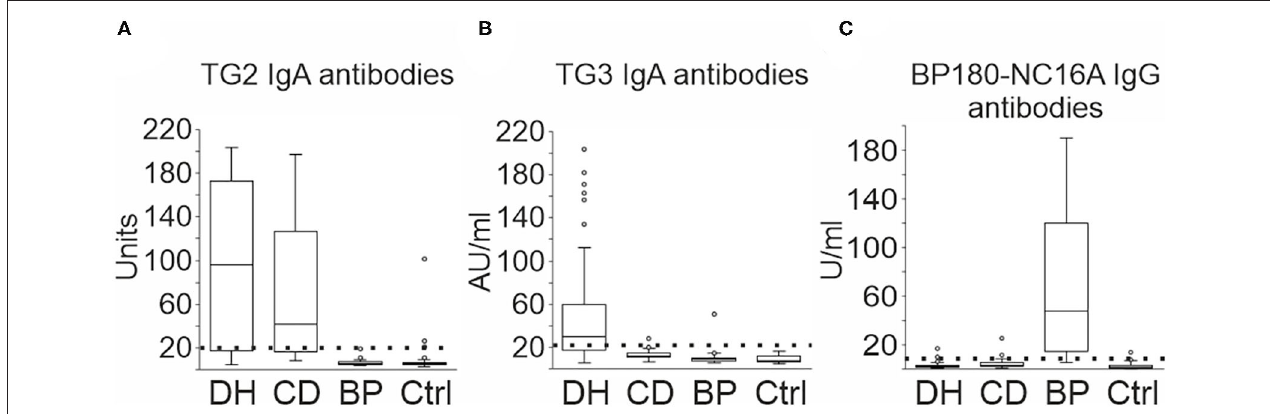
FIGURE 1 | TG2, TG3, and BP180-NC16A autoantibodies in DH, CD, and BP serum samples. 46 DH, 43CD and 34 BP, and 48 control sera were tested for IgA or IgG reactivity against TG2, TG3, and BP180-NC16A using ELISA. (A) Increased TG2 IgA autoantibodies were detected in 33 DH samples, 31CD samples, and 3 controls. (B) Increased TG3 IgA autoantibodies were detected in 29 DH samples, one CD, and one BP sample. (C) Increased BP180-NC16A IgG autoantibodies were detected in 28 BP, three DH, two CD, and two control samples. The boxplot represents the distribution of values in varying units as given by the manufacturer. Boxes depict the 25 and 75th percentiles (interquartile range, IQR) and line in the box is median. Whiskers indicate last values within 1.5 times the IQR from the median, and outliers are marked with circles. BP, bullous pemphigoid; CD, coeliac disease; Ctrl, control; DH, dermatitis herpetiformis.